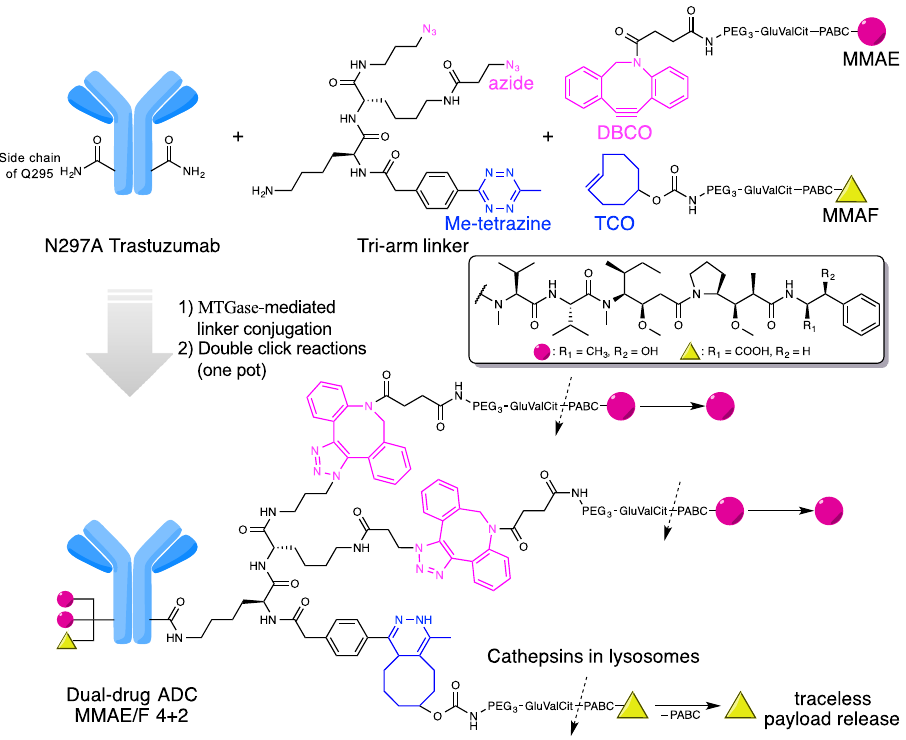
Fig. 1 Molecular design and conjugation strategy for generating dual-drug ADCs. MTGase-mediated conjugation of bi-functional branched linkers and following orthogonal click reactions with two payload modules afford homogeneous dual-drug ADCs with de fi ned DARs (magenta circle: MMAE; yellow triangle: MMAF). Preparation of anti-HER2 ADC with a DAR of MMAE/F 4 + 2 is shown as an example. The glutamic acid – valine – citrulline (GluValCit) – PABC linker ensures in vivo stability, while allowing for quick and traceless release of payloads upon internalization and following cathepsin-mediated cleavage in lysosomes. DAR, drug-to-antibody ratio; DBCO, dibenzocyclooctyne; MTGase, microbial transglutaminase; PABC, p -aminobenzyloxycarbonyl; PEG, polyethylene glycol; TCO, trans